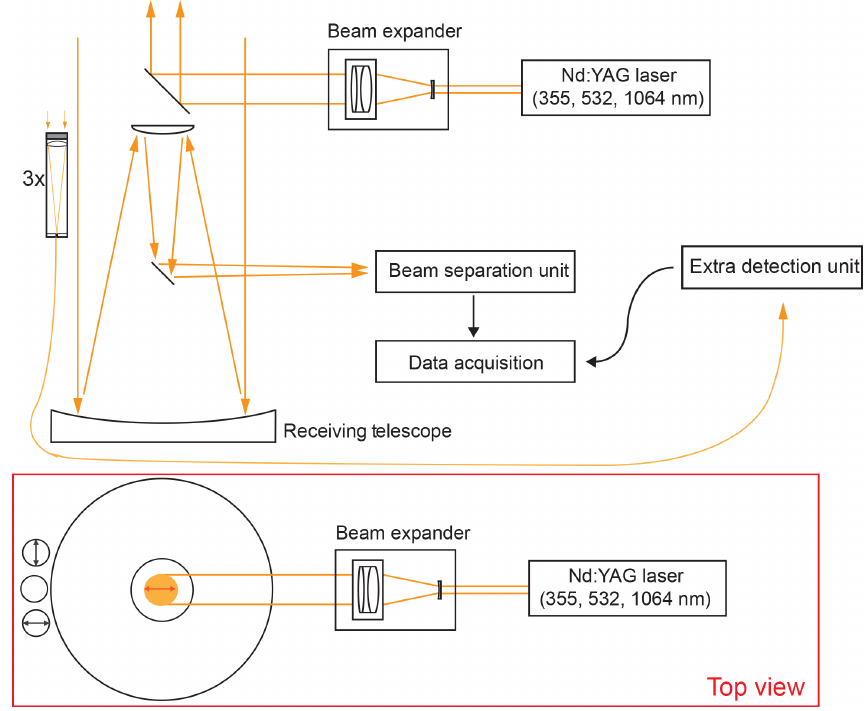
Figure 1. Overview of the EARLINET lidar MARTHA. The three-signal receiver unit of the new polarization lidar setup (details are shown in Fig. 2) is integrated into the MARTHA telescope construction (left side in both of the sketches). The outgoing laser beam is 54cm away from the new polarization-sensitive receiver unit. The main plane of linear polarization of the laser pulses and the polarization sensitivity of cross- and co-polarized receiver channels are indicated by arrows in the top-view sketch.